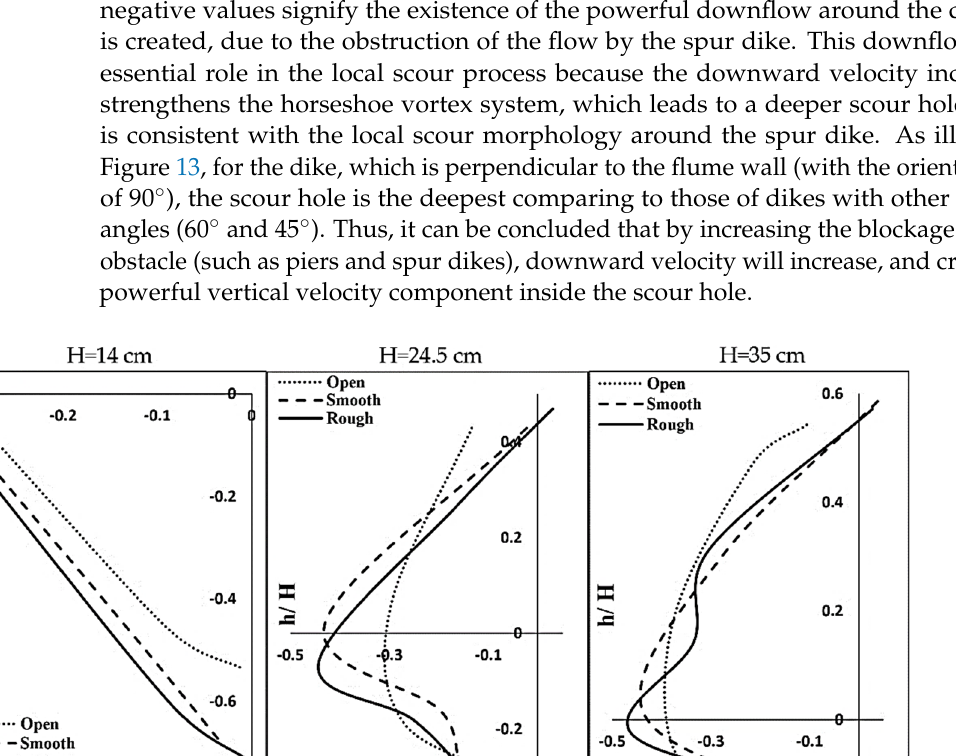
0.25 cm/s error. −